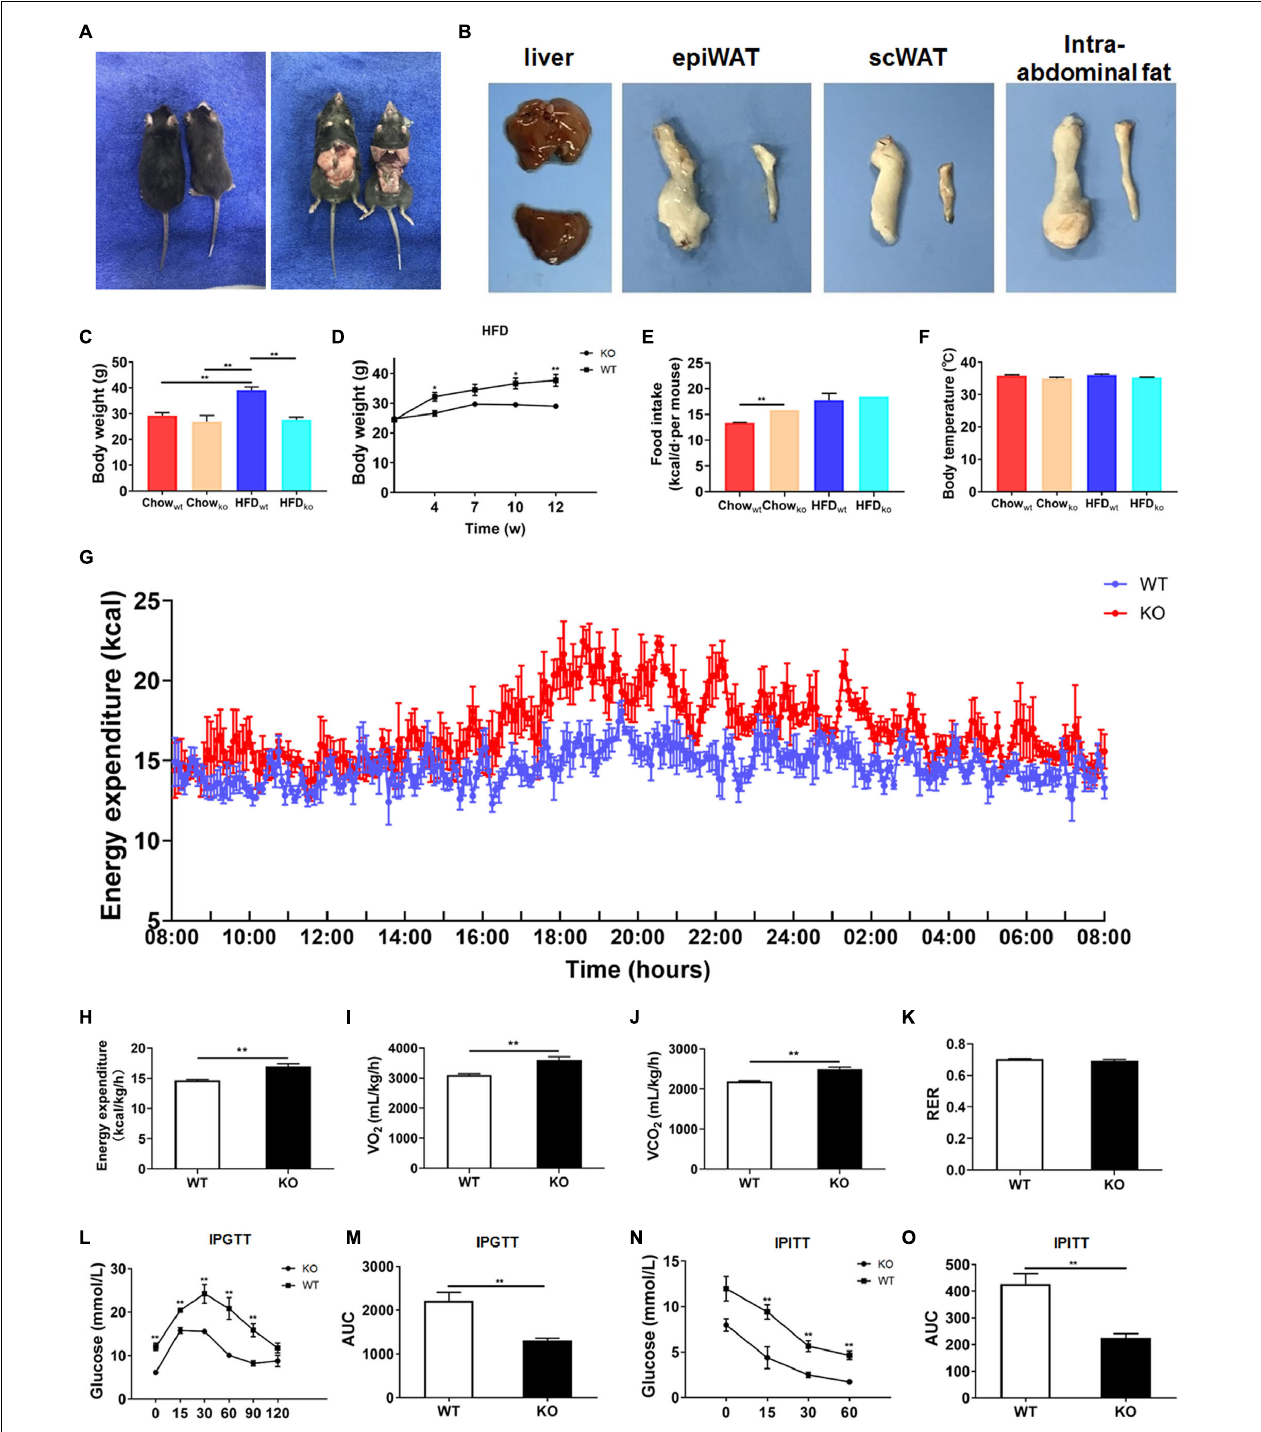
FIGURE 2 | LAMTOR1 MKO mice are resistant to dietary-induced obesity and glucose metabolism disorders. (A) Representative photos of HFD-fed WT (left) and LAMTOR1 MKO (right) mice. (B) Representative images of the liver and white adipose tissue (epiWAT, scWAT, and intra-abdominal fat) of HFD-fed WT (upper or left) and LAMTOR1 MKO (below or left) mice. (C) Body weight after 3 months of intake of Chow diet or HFD. (D) Body weight variation during the intake of HFD. (E) Food intake. (F) Body temperature. (G-K) Metabolic cages-related results of (G,H) energy expenditure, (I) oxygen consumption, (J) CO 2 production, and (K) RER. The test was conducted at 12 weeks of age with HFD, and prior to metabolic cage test, the mice had been fed with HFD for 4 weeks. ( L–O) IPGTT (glucose 1.5 g/kg) and IPITT (insulin 1 U/kg) were performed after 3 months of HFD intake. The data expressed as the mean ± SEM, n = 4–6. ** P < 0.01 vs. WT. epiWAT, epididymal white adipose tissue; HFD, high-fat diet; IPGTT, intraperitoneal glucose tolerance test; IPITT, intraperitoneal insulin tolerance test; MKO, myeloid-specific knockout; RER, respiratory exchange ratio; scWAT, subcutaneous white adipose tissue; SEM, standard error of the mean; WT, wild-type.